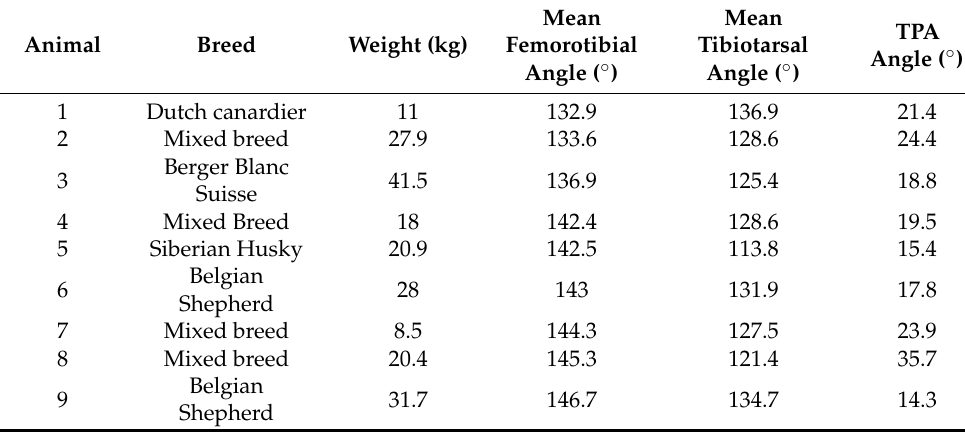
Table 1. Breed, weight, femorotibial angles, tibiotarsal angles and tibial plateau angles.